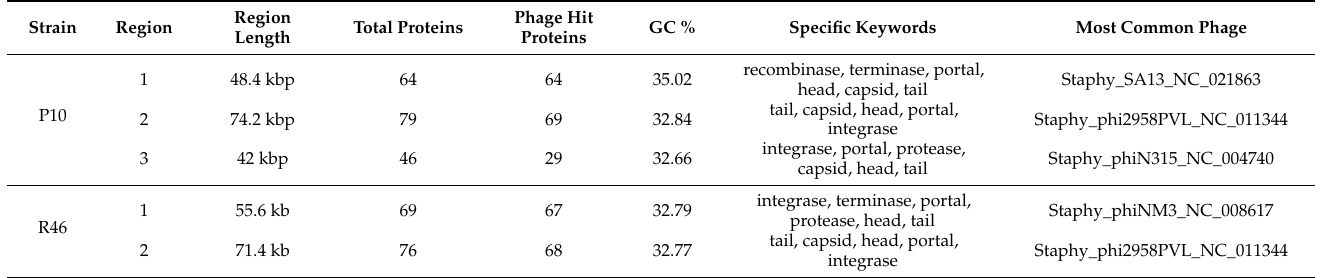
Table 4. Characteristics of complete prophages present in MRSA ST113 strains P10 and